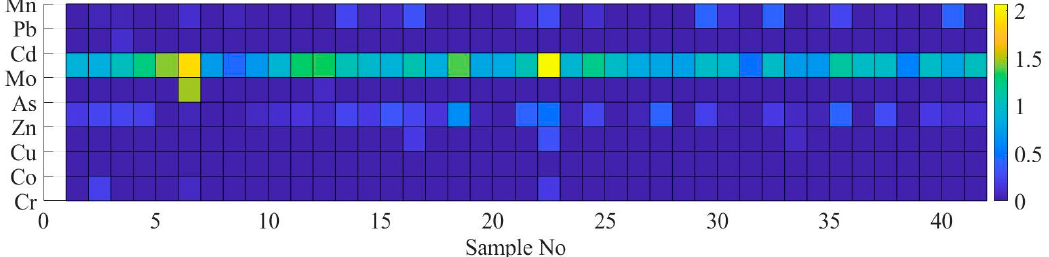
Figure 5. Results of geo-accumulation factor for heavy metals in each samples.